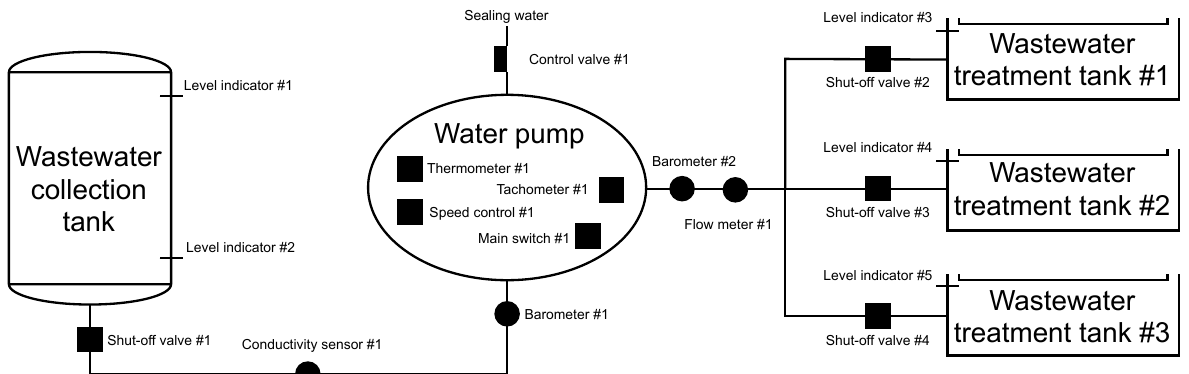
Figure 13. Scheme of wastewater